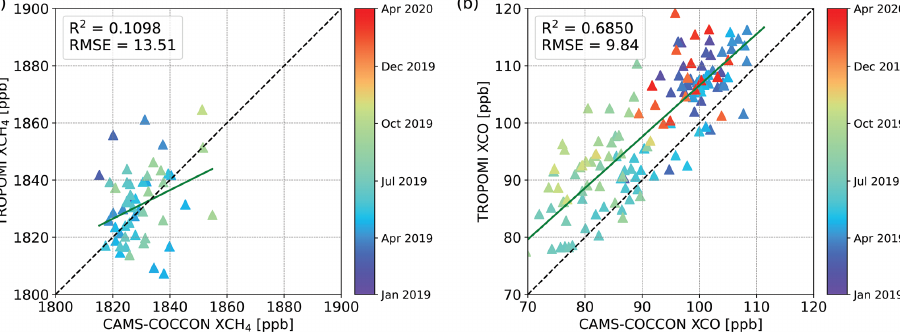
Figure 18. Correlation plots of (a) TROPOMI XCH 4 and (b) TROPOMI XCO with respect to CAMS-COCCON at Peterhof. All satellite data were adjusted for the CAMS a priori